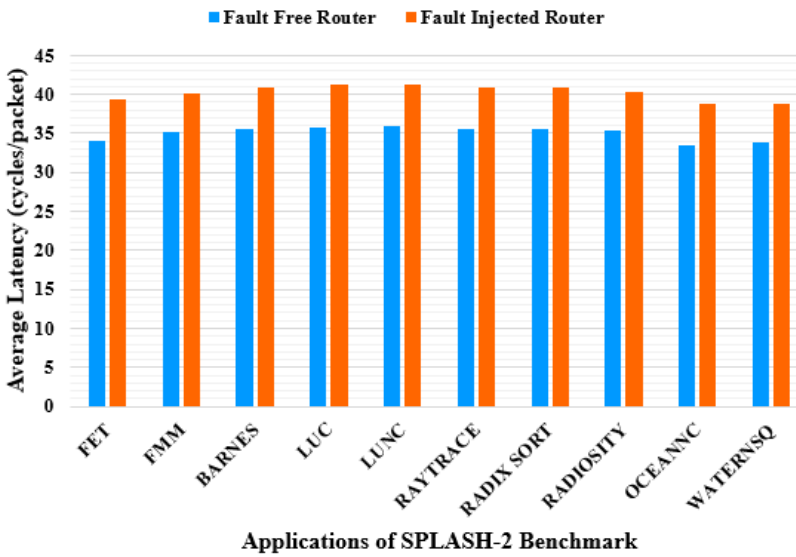
Figure 13. Latency comparison under SPLASH-2 benchmark traffic pattern.